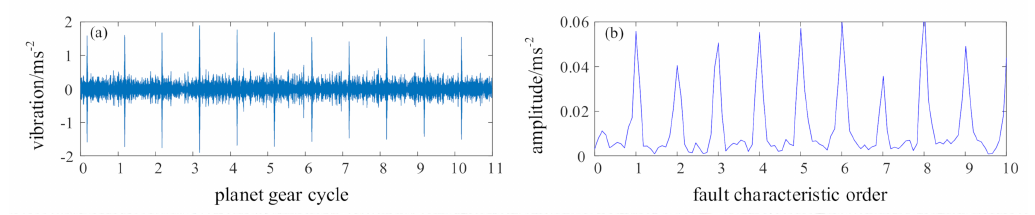
Figure 15. MED signal: ( a ) signal waveform; ( b ) envelope order